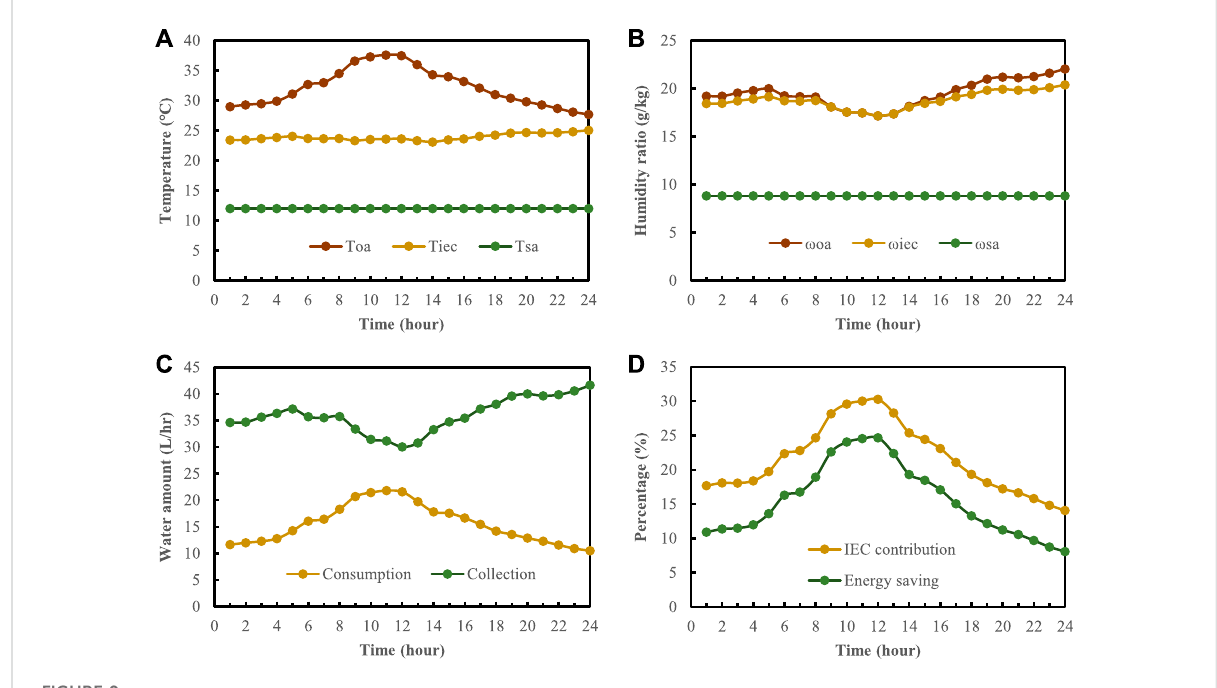
FIGURE 9 DailyperformanceofIEC-MVC inJeddahonJul-152021: (A) temperature change, (B) humiditychange, (C) water collectionandconsumption, and (D) ∅ IEC and energy saving.